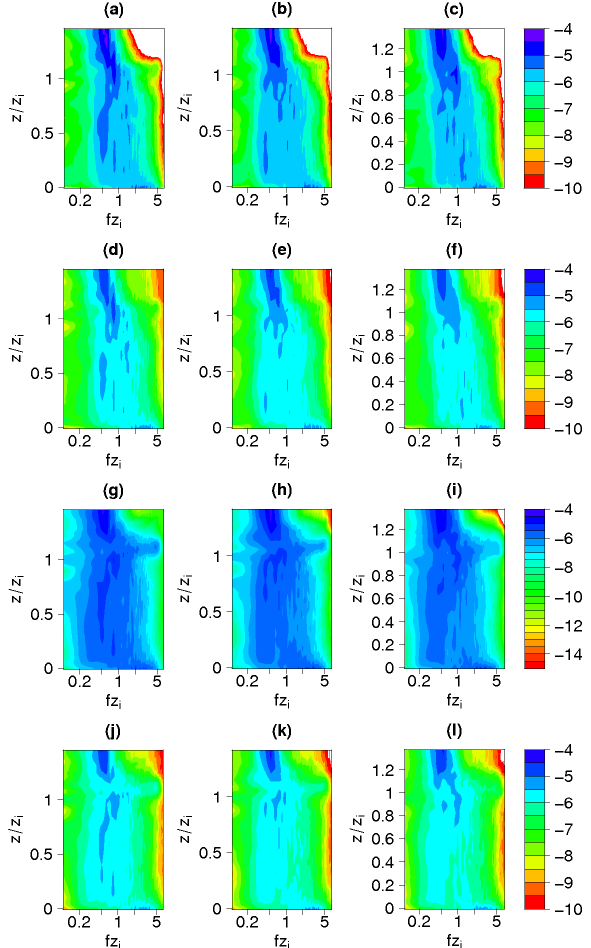
Fig. 10. Normalized copectra [P m] for low wind speed scenario as a function of length scale increasing from left to right (a–c) surface temperature and air temperature (d–f) surface sensible heat and air temperature (g–i) soil moisture and air specific humidity (j–l) sur- face latent heat and specific